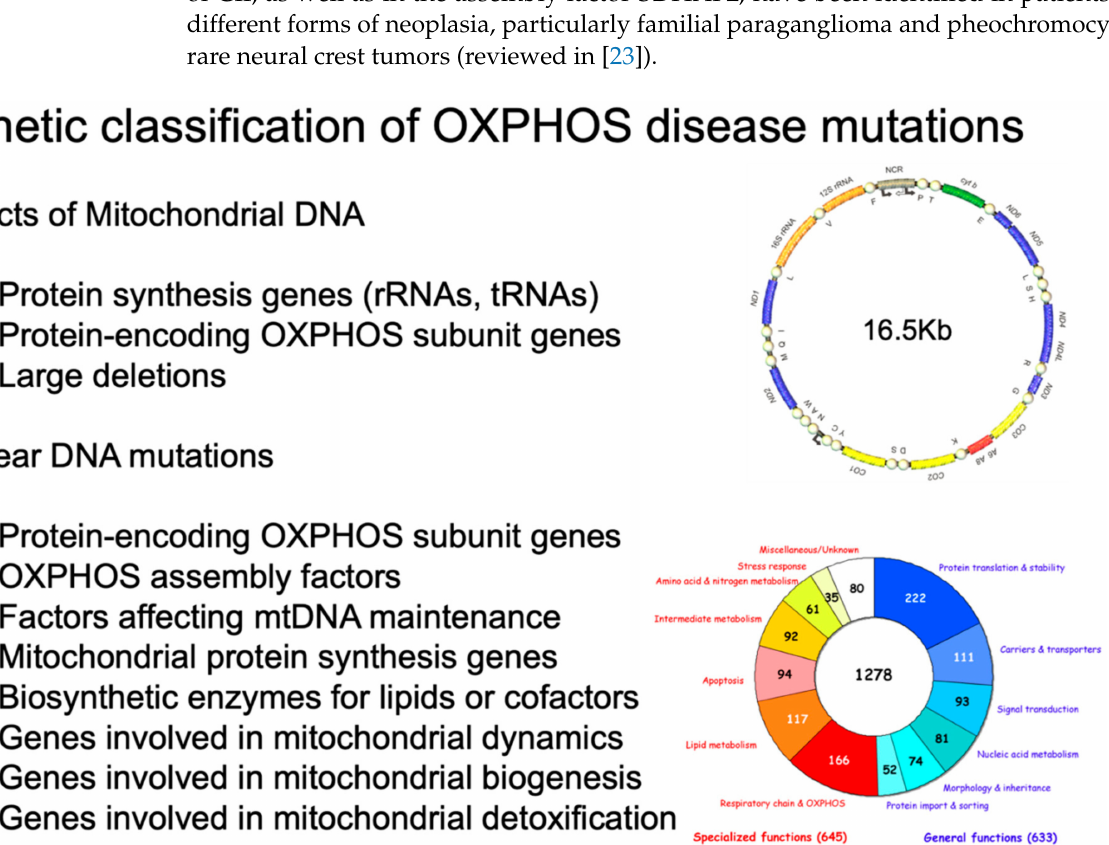
Figure 1. Genetic classification of OXPHOS disease mutations. On the upper right, a scheme of human mtDNA is depicted. The two ribosomal RNA genes are in dark yellow. CI genes are in blue; the CIII gene is in green; the CIV genes are in light yellow; and the CV genes are in red. The non- coding region (NCR) is in beige. The tRNA genes are represented by circles and designated according to the single-letter code of the corresponding amino acid. On the bottom right, a pie chart summarizes the current knowledge about the human mitochondrial proteome. Different colors indicate different categories of proteins. Adapted from [12] under the Creative Commons Attribution